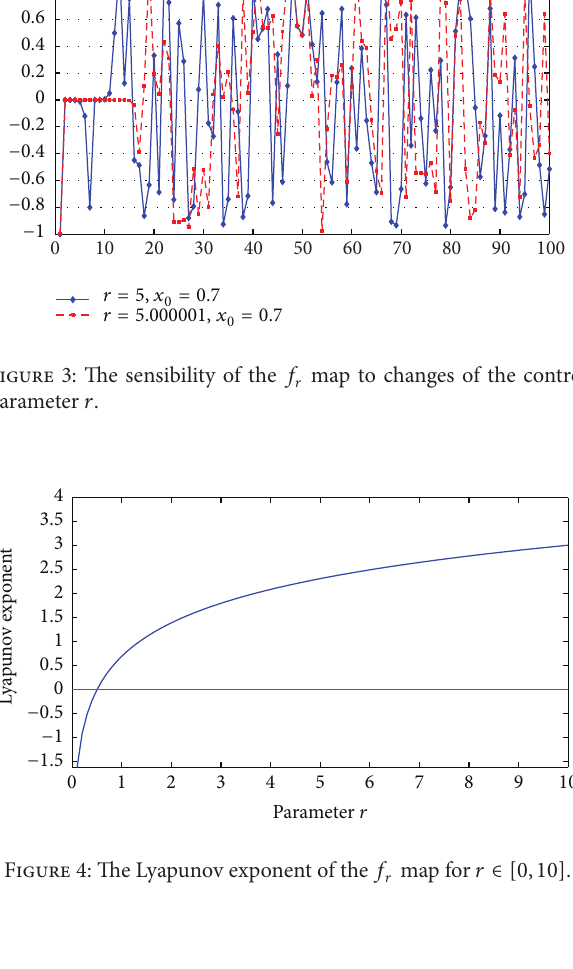
Due to the fact that the random variables 𝑋 and 𝑌 cor- respond to time average of 𝑓 𝑟 after time 𝑛 and space average, respectively,, the purpose of the test is to establish if the two experimental sets of data derive from populations with the same distribution or not, in respect to Birkhoff’s theorem. The analysis is based on the experimental distribution functions Fe 𝑋 and Fe 𝑌 of the two random variables 𝑋 and 𝑌